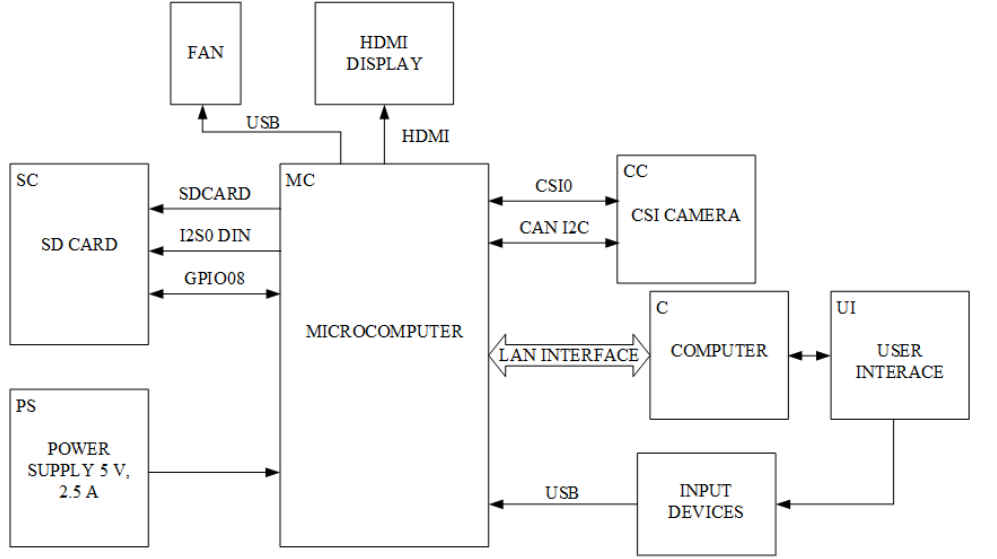
Figure 2. Hardware setup schematic of object detector. Implementation for a SMD component